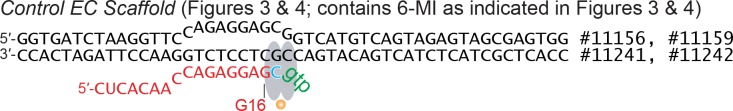
Control EC scaffold used for 6-MI translocation assays in Figures 3 and 4.Full sequences of oligonucleotides are given in Supplementary file 1. 6-MI is present at the locations indicated in Figures 3 and 4.